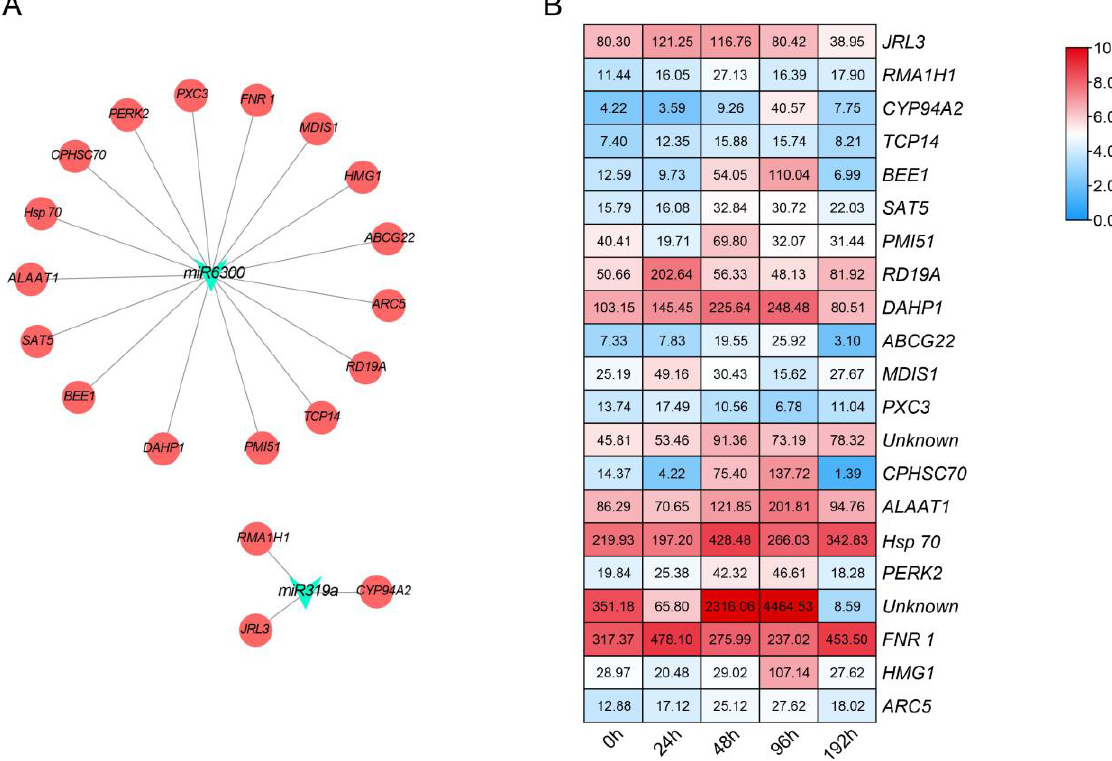
Figure 4. Target genes of selected miRNAs analyzed on the basis of the transcriptome of cucumber inoculated with Foc. ( A ) Predicted regulatory networks between miR6300 and miR319a and the differentially expressed target genes; ( B ) Analysis of target gene expression profiles in cucumber roots after the Foc inoculation. ‘Rijiecheng’ roots inoculated with Foc collected at different post-inoculation time-points (0, 24, 48, 96 and 192 h) were used to analyze the target gene expression patterns. Genes more highly or more weakly expressed in the roots were colored red and blue, respectively. The RNA-seq data were submitted to the NCBI database (accession number